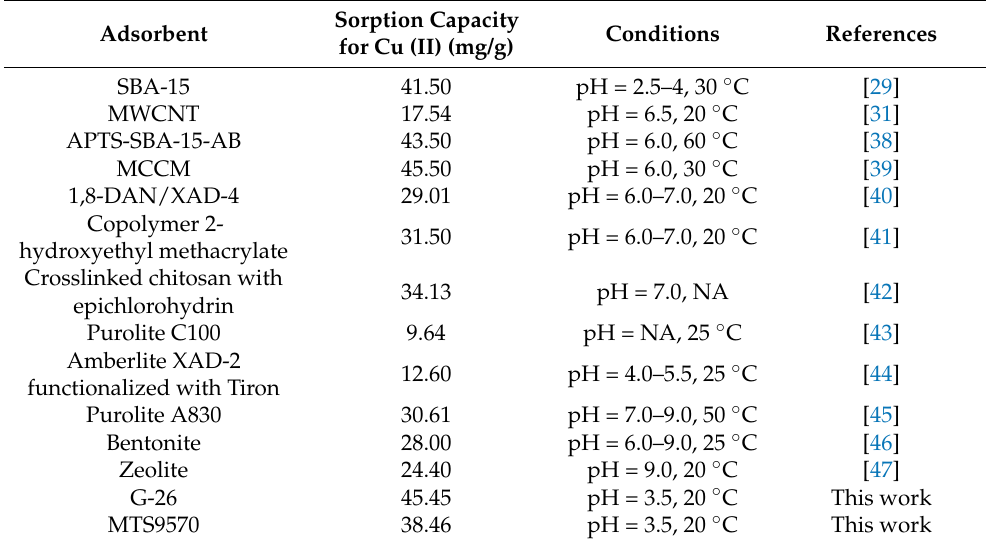
Table 3. Comparison of maximum adsorption capacity of G-26 and MTS 9570 resins with some other adsorbents for adsorption of Pb(II).